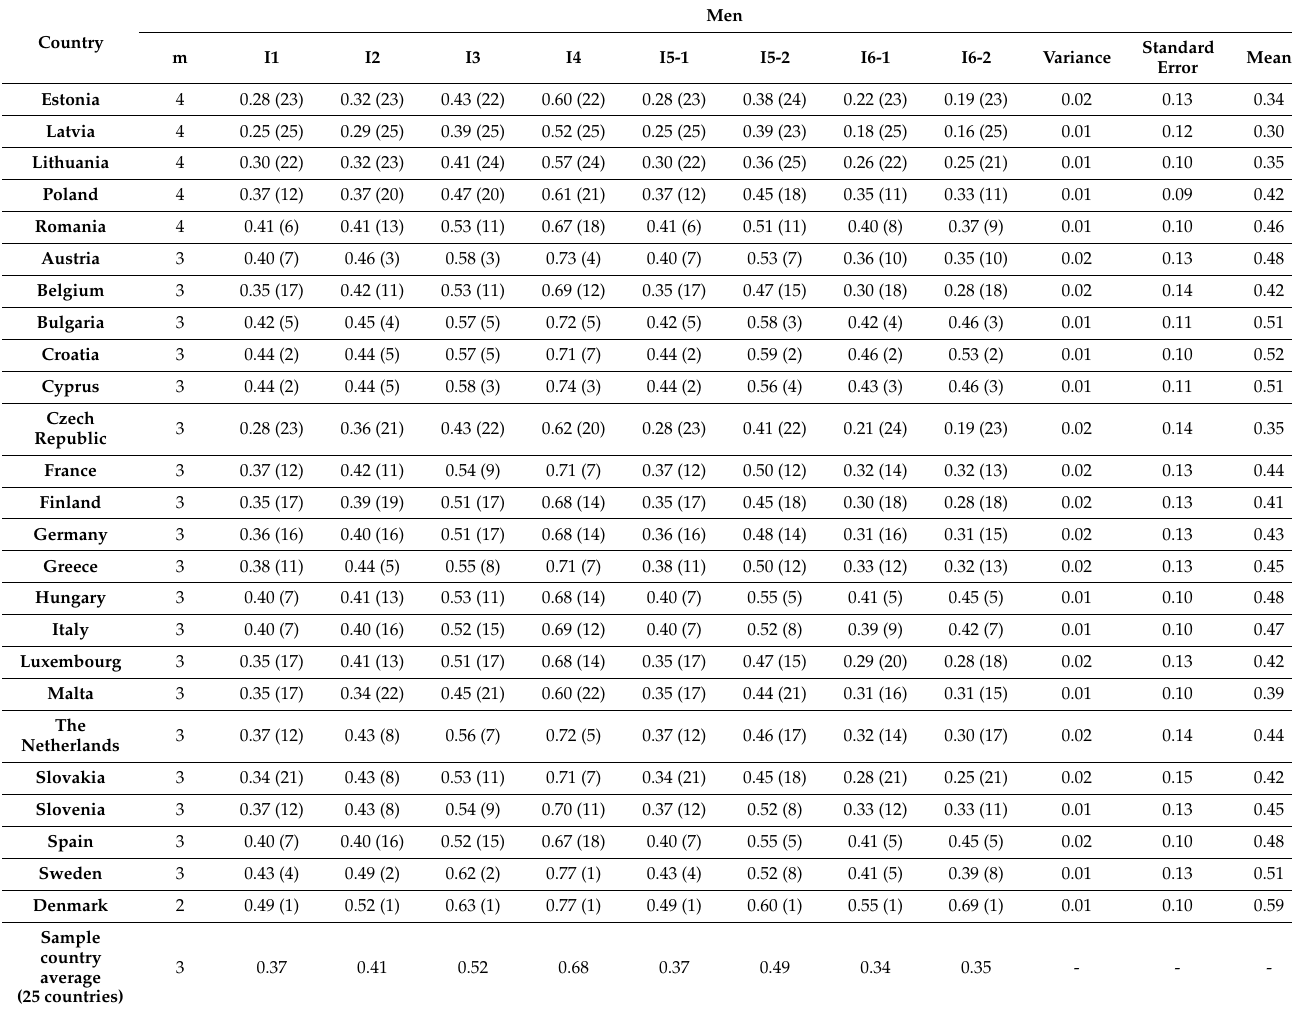
Table 9. Inequality indicators in self-perceived health in Wave 8 (2020) for